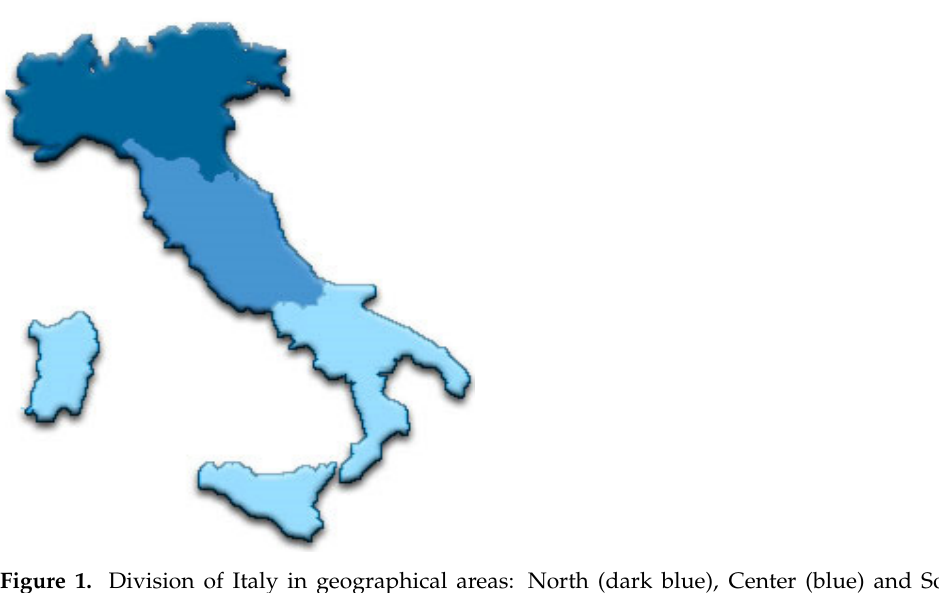
Figure 1. Division of Italy in geographical areas: North (dark blue), Center (blue) and South (light blue).